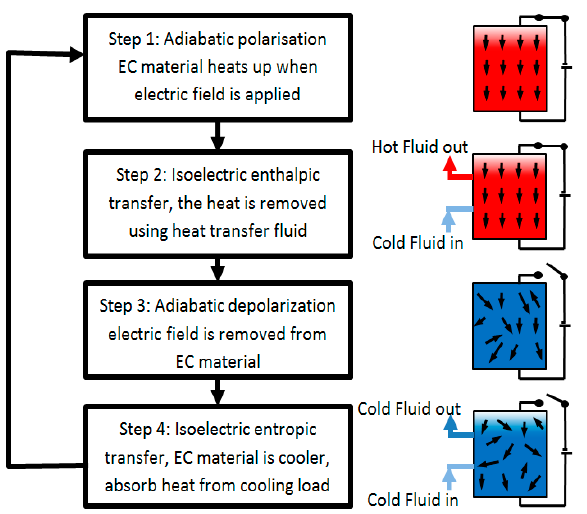
Figure 2. Schematics showing the basic working principle of Electrocaloric Refrigeration.